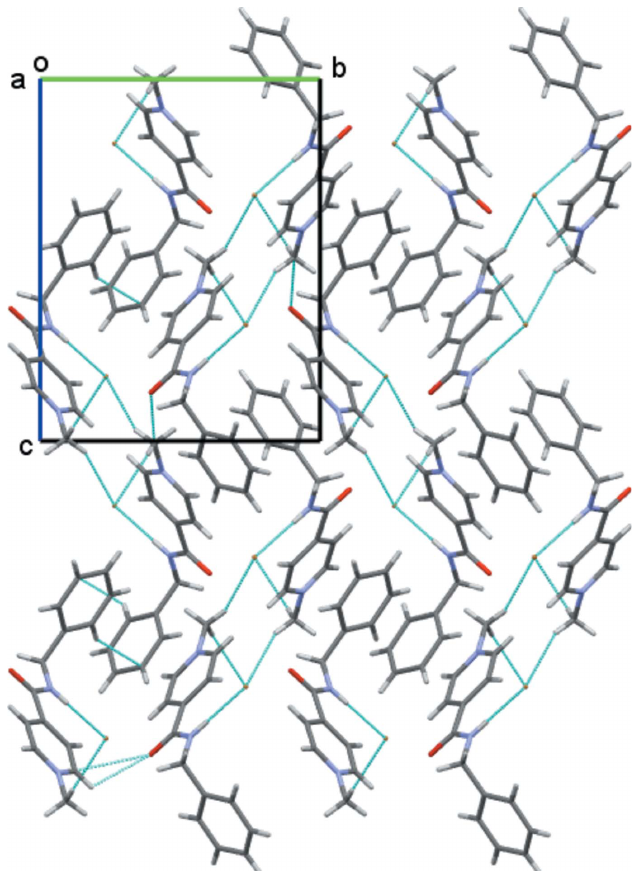
Figure 2 Crystal structure of 4-[(benzylamino)carbonyl]-1-methylpyridinium chloride. X —H (cid:2)(cid:2)(cid:2) Cl hydrogen bonds are shown as dashed cyan lines.